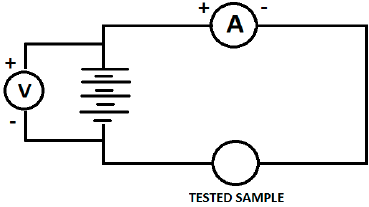
Figure 4. Schematic for Calculation of Electrical conductivity.